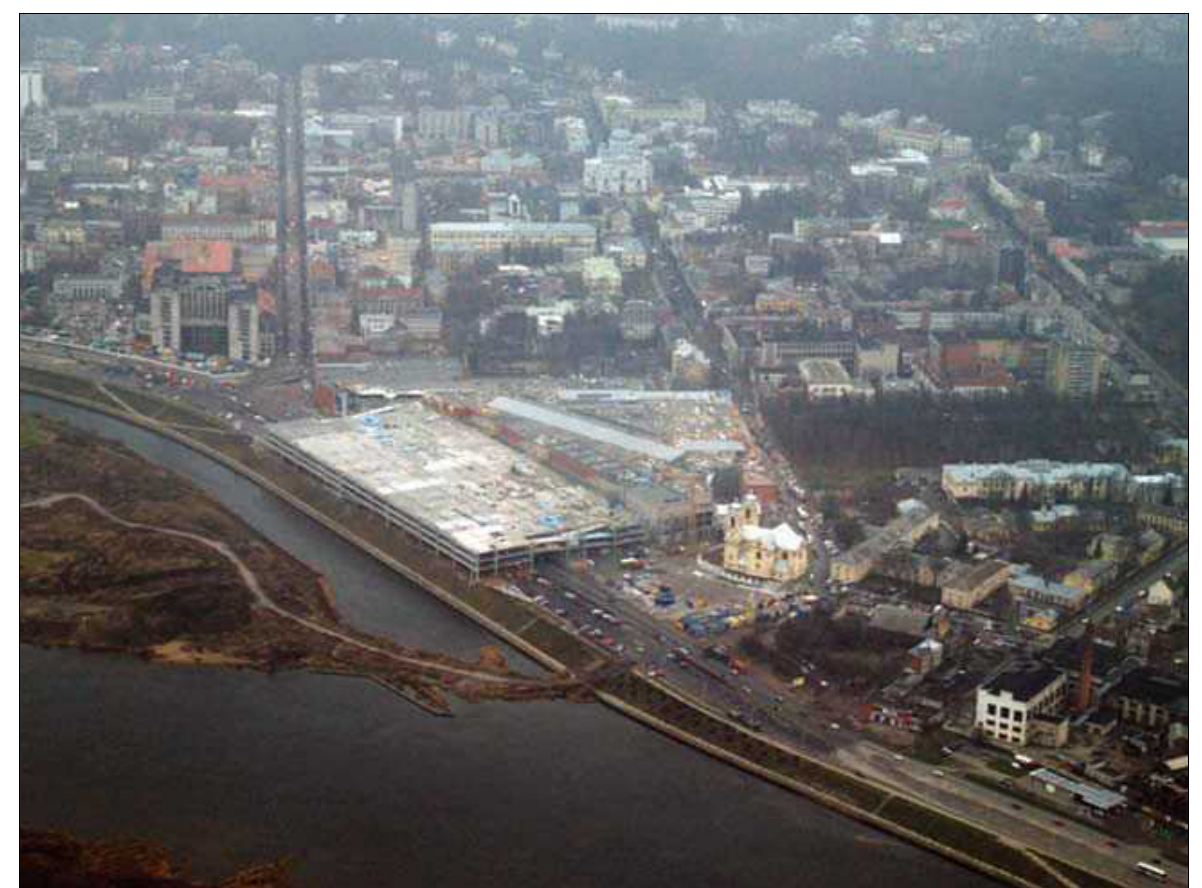
Fig. 2. bir­d’s eye view of “a­kr­opolis“ shopping center­ in kau­nas. a­r­chitects G. Ju­r­evičiu­s, a­.